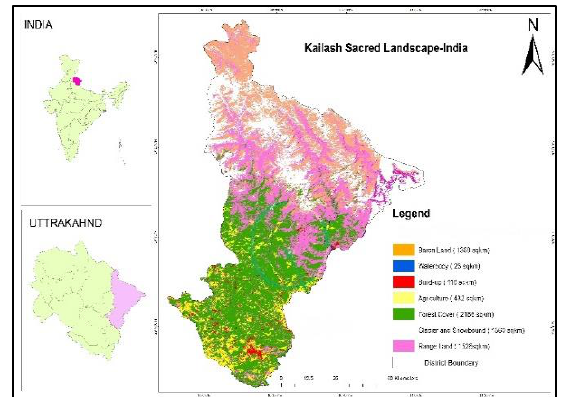
Figure 1: Map of the study area.